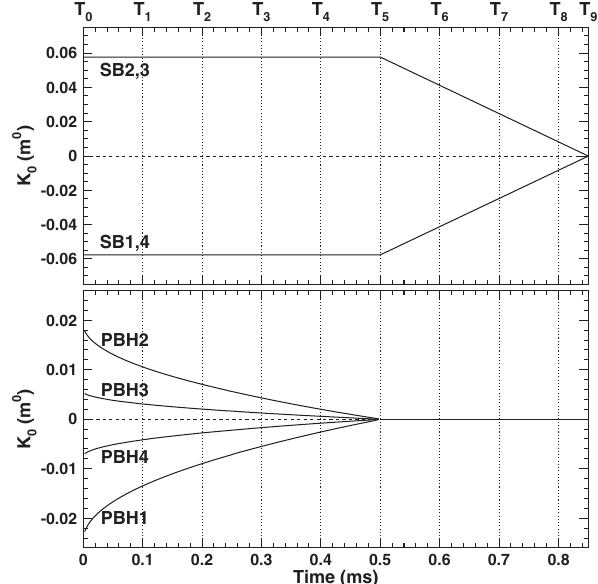
FIG. 5. Excitation field forms of SBs (top) and PBHs (bottom) required for 150 π mm mrad transverse painting, where k 0 is R ð B =B ρ Þ ds , where B ρ is the momentum rigidity. defined as y